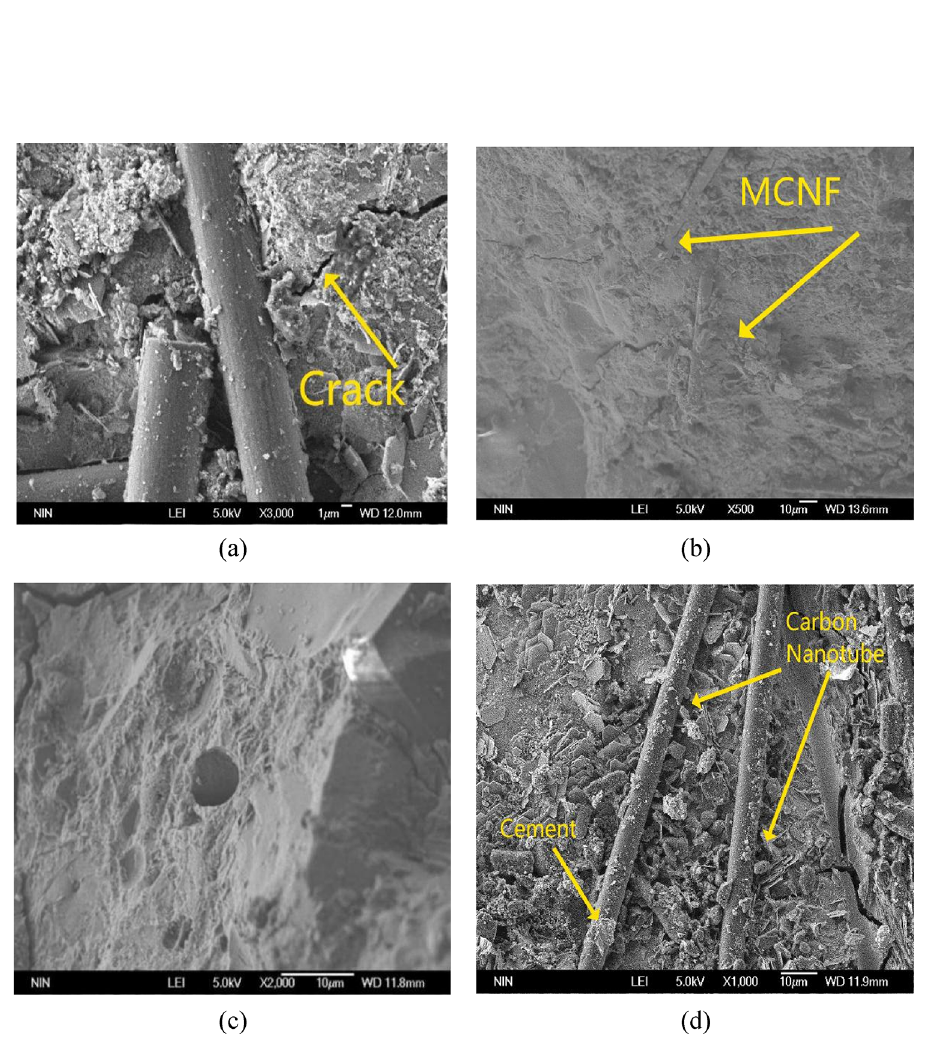
Figure 8. SEM pictures of fracture surface of MCNF